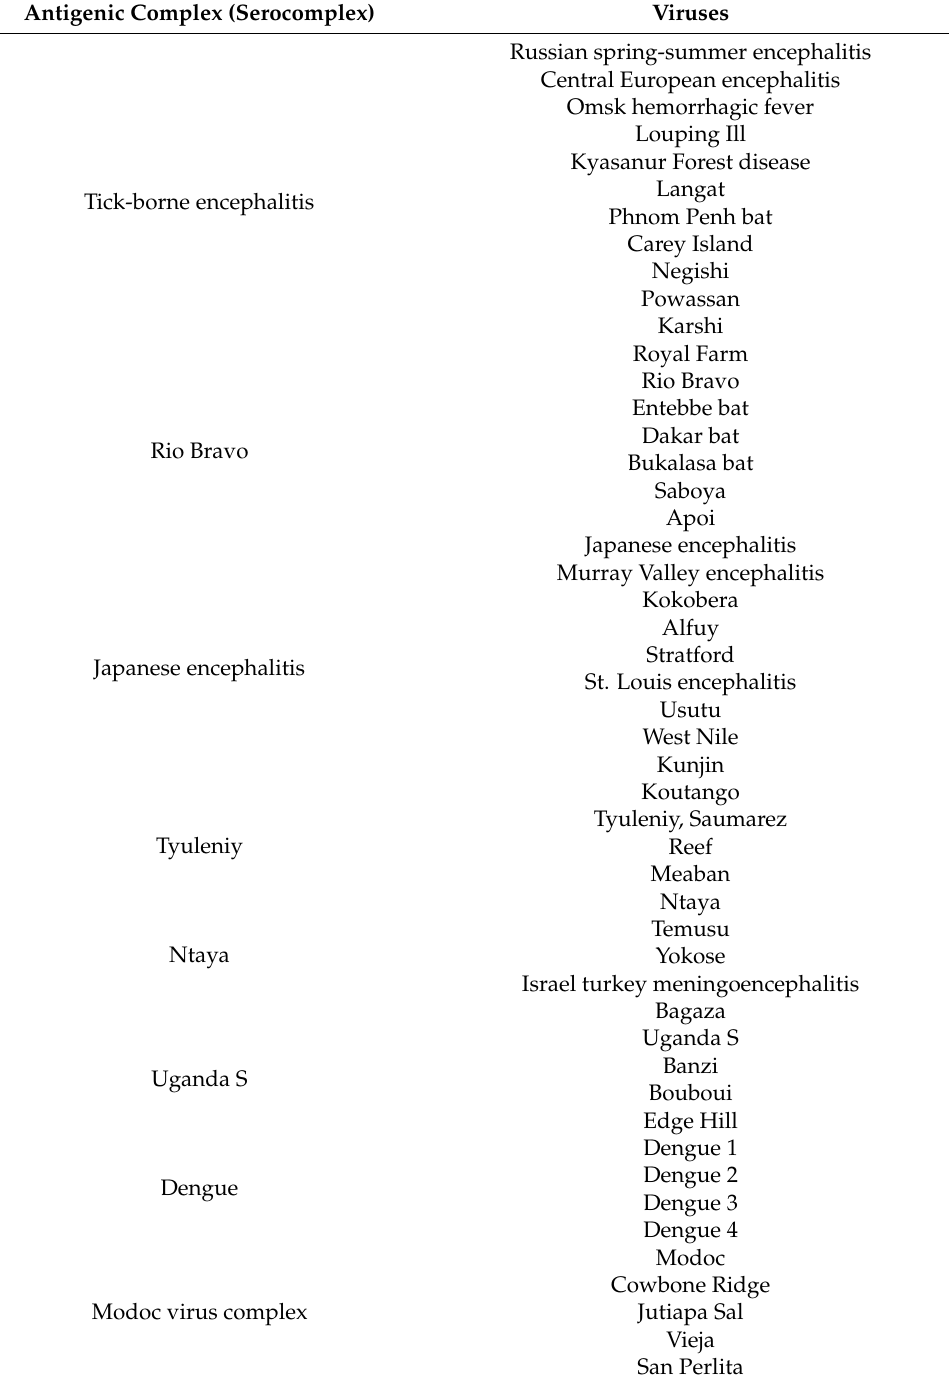
Table 1. Flaviviruses classification into